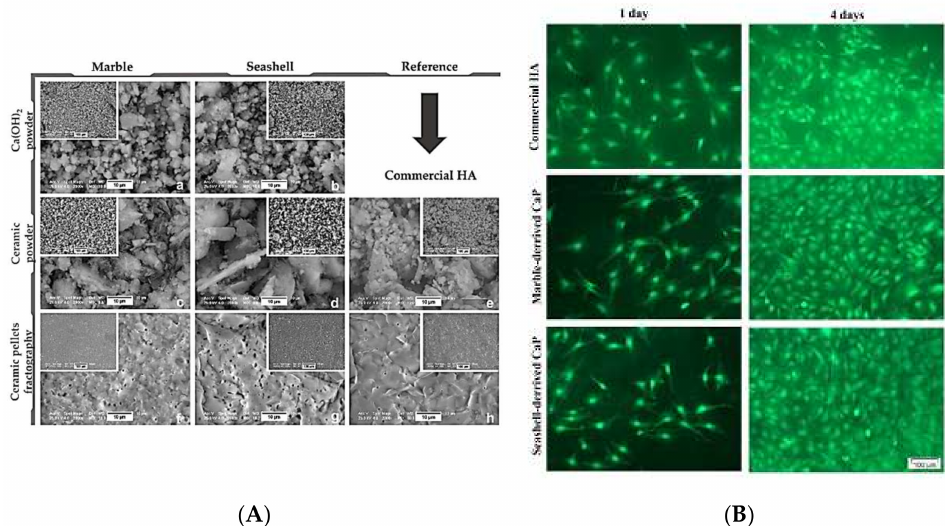
Figure 5. ( A ) SEM images of reference, seashell, and marble materials (on the magnification of 10 and 100 µ m); ( B ) Fluorescence microscopy images of the MC3T3-E1 cells